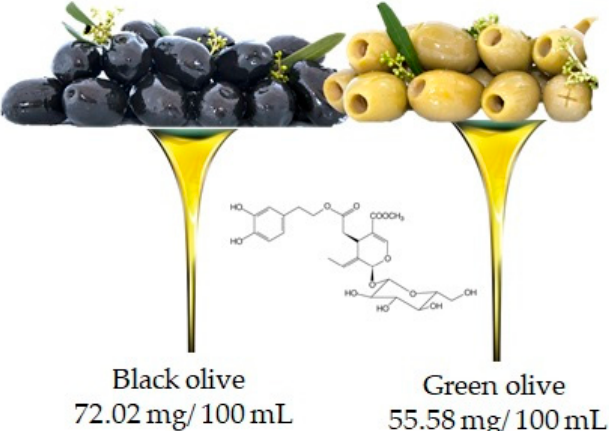
Figure 6. Olive is the main food that contains oleuropien, according to the database Phenol-Explore (http://phenol-explorer.eu/ accessed on 29 January 2021). There is no value reported for the USDA Database for the flavonoid content of selected foods (https://www.ars.usda.gov/ accessed on 13 February